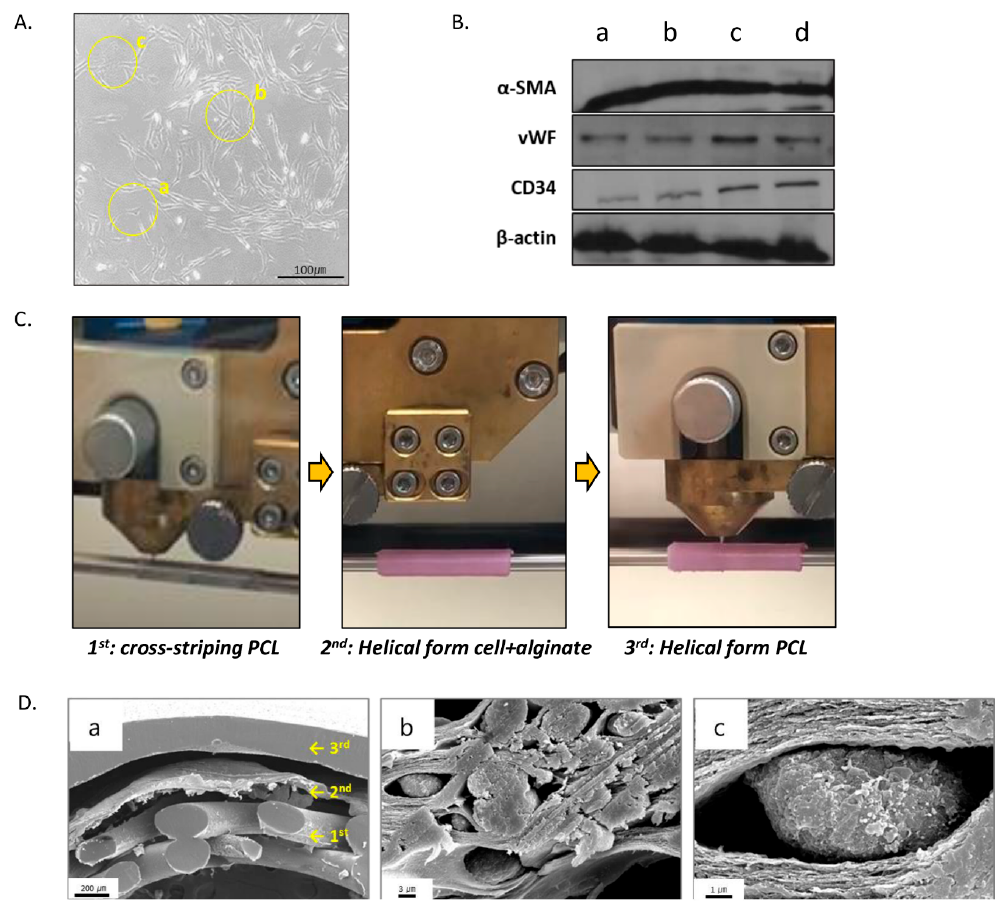
Figure 2. Validation of the materials and products ( A ) Morphology of the canine b-MSCs under a microscope (Nikon) (A-a) rapidly self-renewing cells, (A-b) spindle-shaped cells, and (A-c) flattened cells with nuclei. The original magnification of photomicrographs was X100. ( B ) b-MSCs differentiation in the cell-derived group (n=4, a–d) was confirmed by Western blot analysis of respective differentiation markers; a-smooth muscle actin ( α -SMA), von Willebrand Factor (vWF), CD34, and β -actin. ( C ) Prepared vascular scaffold by 3D printing (1st, cross-striping PCL; 2nd, , helical form cell + alginate; 3rd, helical form PCL). ( D ) Cross-section SEM micrographs of pre-implanted artificial vessel by three-dimensional printing device. (D-a) Three layer artificial vessel (1st, porous structure PCL; 2nd, 1 × 10 6 cells + 3% sodium alginate solution + 1% cacl 2 ; 3rd, non-porous PCL) (D-b) The middle layer combined with b-MSCs and alginate. (D-c) b-MSCs implanted between the alginate gel in the middle layer. Evaluated under original magnification for photomicrography. Magnification of A, B, and C was X40; X2.00K; X10.00K, respectively.